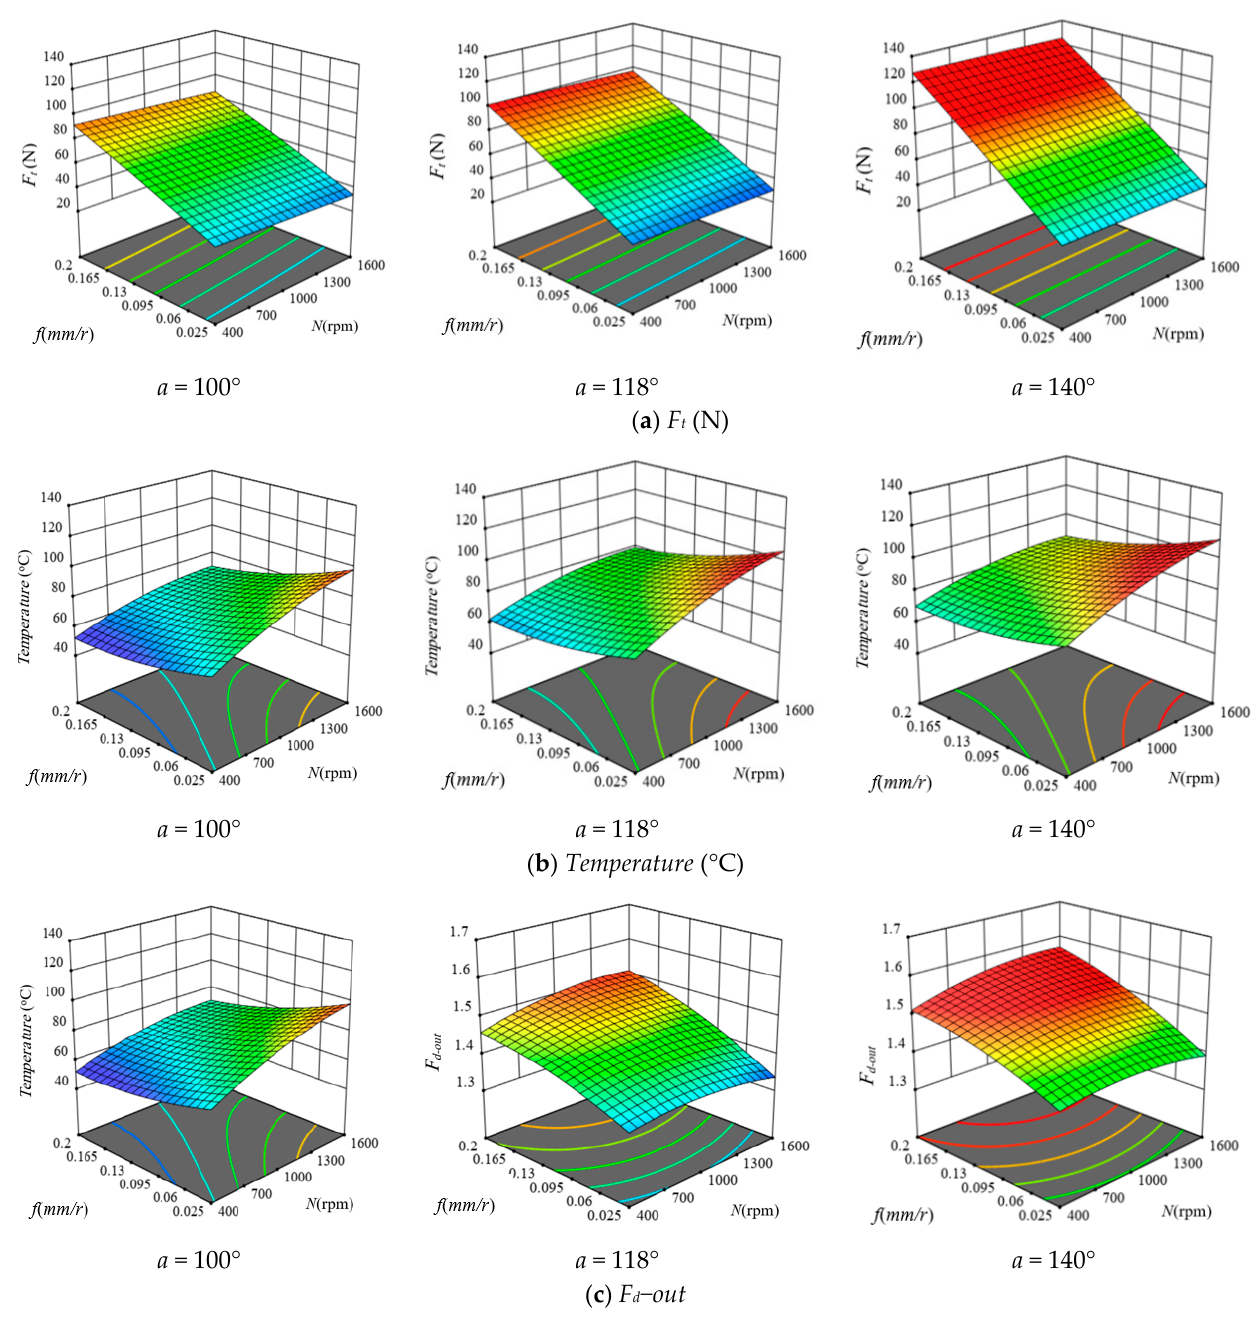
Figure 12. Response surface plots of drilling parameters effect on the machinability properties of GFRP composite with thickness of 5.3 mm: ( a ) Ft, ( b ) temperature, and ( c ) Fd −